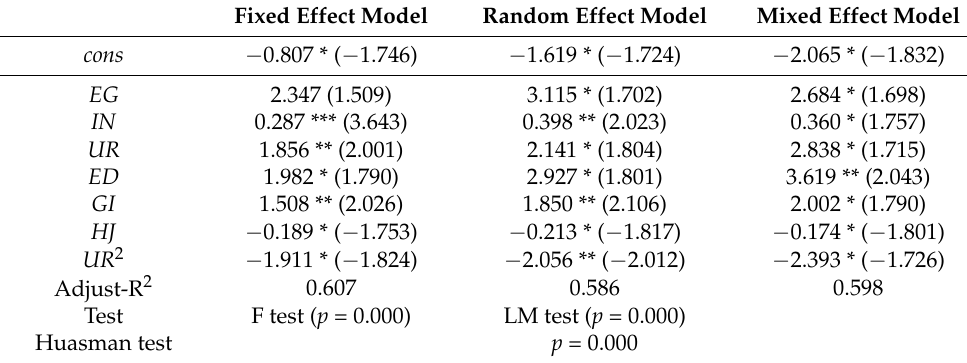
Table 9. Results of robustness test